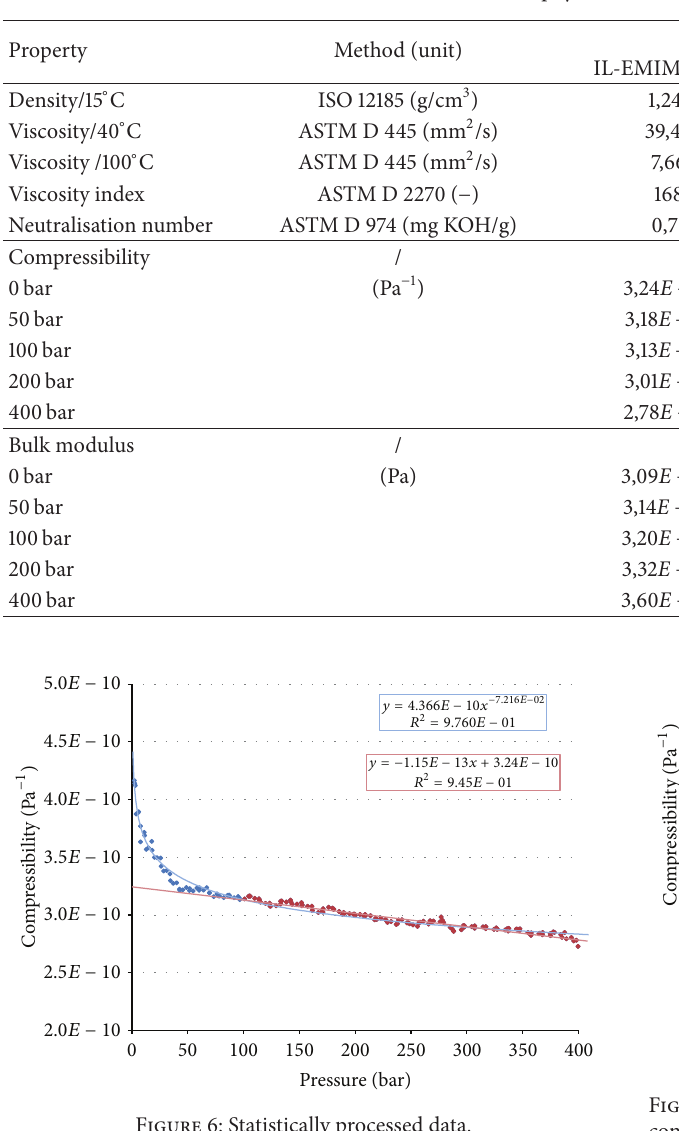
Table 9: Chemical-physical characteristics of tested fluids.